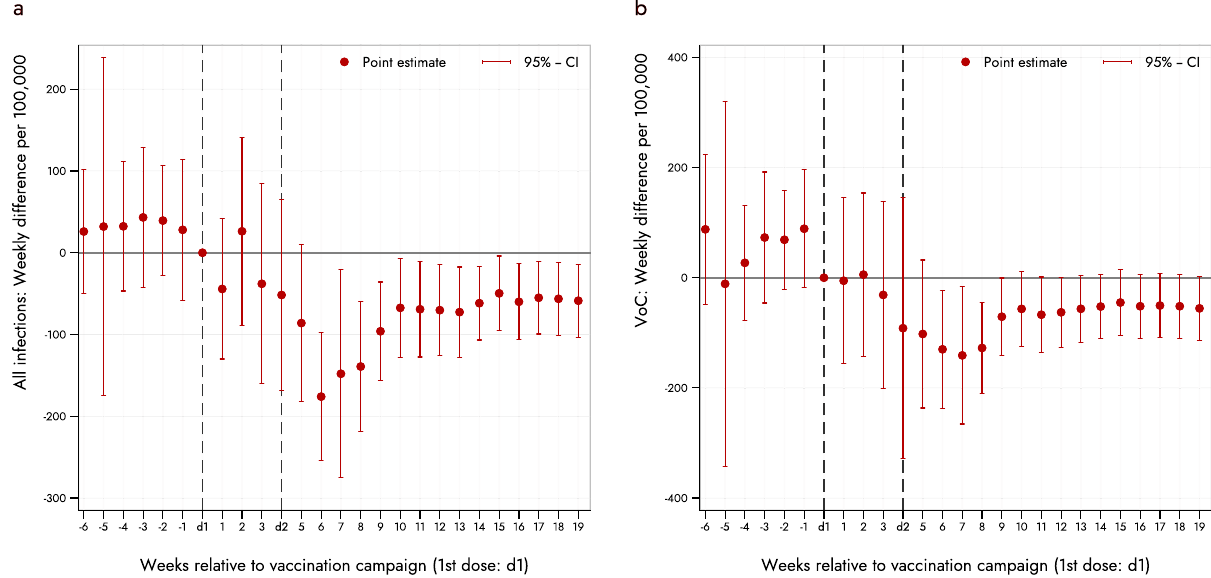
Fig. 4 Difference in weekly infections of SARS-CoV-2 and its variants of concern (VoCs) in Schwaz and the neighboring municipalities. The fi gure displays the results from regression Eq. (1) using weekly cases (per 100,000) as outcome variable for Schwaz and its bordering municipalities. ( a ) refers to all infections, and ( b ) to the sum of variants Beta, Alpha/E484K and Delta. The plotted points are the weekly coef fi cients β k which represent the mean difference in weekly cases between Schwaz and the border municipalities relative to the reference week d1 (conditional on municipality- and week- fi xed effects). The point coef fi cient for each week is shown together with the 95%-con fi dence interval. The horizontal axis displays the number of weeks relative to vaccination campaign (dose 1). The vertical dashed lines represent the fi rst dose (d1) and the second dose (d2) administered as part of the mass vaccination